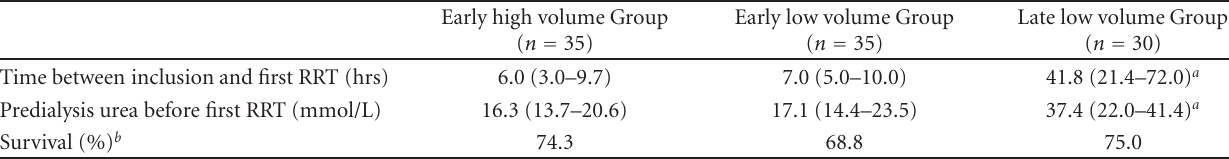
Table 5: Time to RRT initiation, predialysis urea and patient cohort survival from Bouman et al.